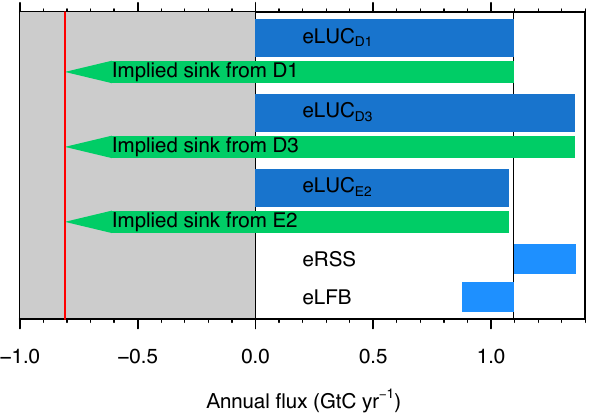
Figure 5. Land use change emissions ( e LUC, dark blue bars) cal- culated from different methodologies and their implied residual ter- restrial C sink (annual flux in GtCyr − 1 , mean over 1996–2005). The total terrestrial C balance is constrained by atmospheric mea- surements and is − 0.8GtCyr − 1 (mean over 1996–2005, (Le Quéré et al., 2014), left vertical line). It is independent of e LUC estimates. The residual terrestrial C sink (green arrow) is defined as the differ- ence of e LUC and the total terrestrial C balance. Depending on the definition of e LUC, the residual C sink is affected by inclusion of secondary fluxes (light blue bars, e RSS and e LFB) into e